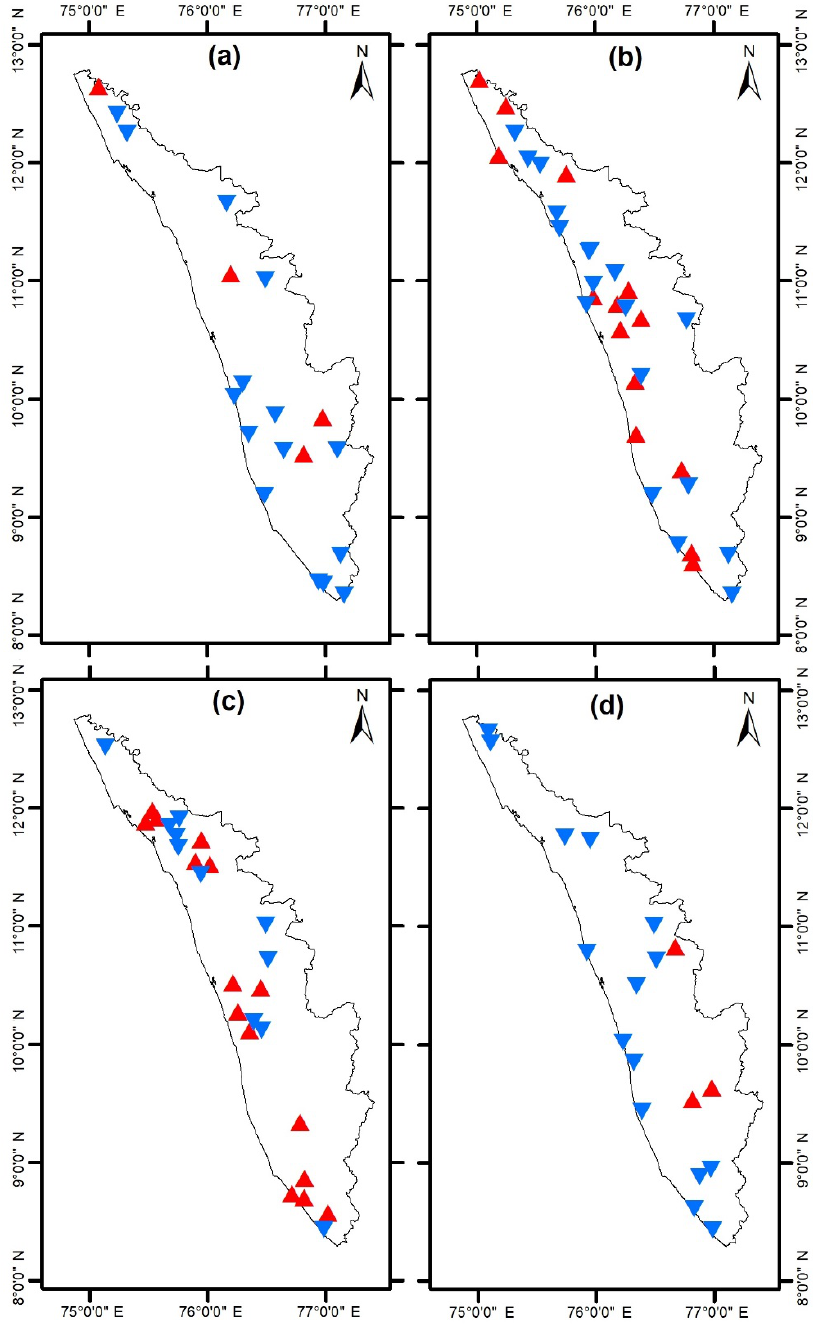
Figure 11. The positive (red) and negative (blue) soil moisture trend of locations 19-32-26-18 during ( a ) January, ( b ) April, ( c ) August, and ( d ) November.